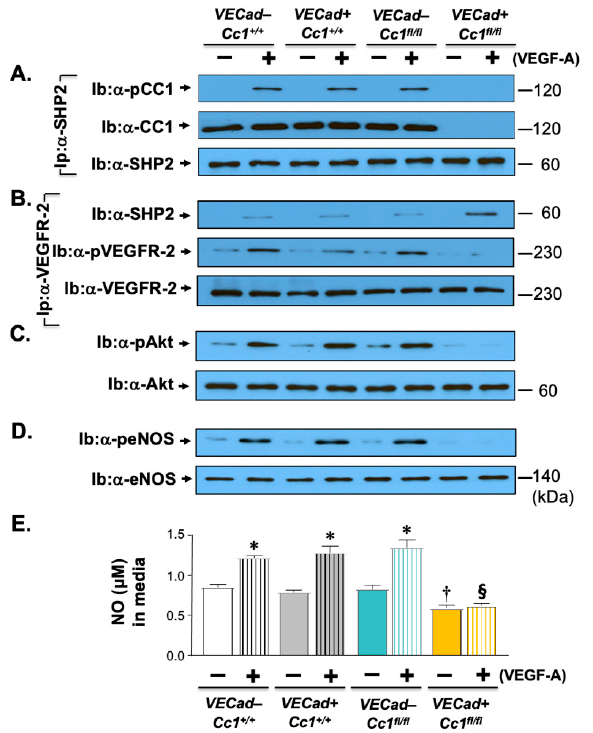
Figure 5. VEGF signaling through the Akt/eNOS pathway in primary endothelial cells. Primary heart endothelial cells were treated with VEGF-A for 5 min, as in the legend of Figure 3. ( A ) Lysates were subjected to immunoprecipitation (Ip) with α -SHP2 antibody followed by immunoblotting (Ib) with antibodies against phospho-CEACAM1 ( α -pCC1), CEACAM1 ( α -CC1), and α -SHP2 to detect these proteins in the α -SHP2 immunopellet. ( B ) Lysates were immunoprecipitated with the α -VEGFR2 antibody followed by immunoblotting with antibodies against α -SHP2, phospho-VEGFR2, and VEGFR2 to assess the level of these proteins in the VEGFR2 immunopellet. ( C , D ) Lysates were subjected to immunoblotting with α -phospho-Akt and α -phospho-eNOS and in parallel gels, against Akt and eNOS, respectively, for normalization. ( E ) Nitric oxide (NO) was essayed in the media of primary heart endothelial cells stimulated with VEGF-A (40 ng/mL) for 20 min. Values were expressed as mean ± SEM. * p < 0.05 vs. no VEGF-A (solid bars)/same genotype; † p < 0.05 vs. ( − ) VEGF-A in all 3 controls; § p < 0.05 (+) VEGF-A (vertical lines) in all 3 controls. 2.6. Increased Fibrosis in Ldlr − / − VECadCre+Cc1 fl/fl Aortic Roots Gomori trichrome staining indicated higher accumulation of fibrotic fibers in the sub- endothelium of the aortic roots of Ldlr − / − VECadCre+Cc1 fl /fl mice compared with their age- matched littermate controls after 4 months (Figure 6A and accompanying graph), but not after 3 months (not shown) of HC feeding. Moreover, qRT-PCR analysis revealed a 2-to- 5–fold increase in the aortic mRNA levels of pro-fibrogenic genes in Ldlr − / − VECadCre+Cc1 fl/fl mice relative to controls: fibronectin, Ctgf, α -Sma, collagen6 α 3, and Tgf β (Table S3). Con- sistent with the ~3-fold decrease in the mRNA level of Smad7 (Table S3), an inhibitor of the TGF β –Smad2/3 canonical pathway, this pro-fibrogenic pathway was more highly ac- tivated (phosphorylated) in Ldlr − / − VECadCre+Cc1 fl/fl aortae relative to controls (Figure 6B).